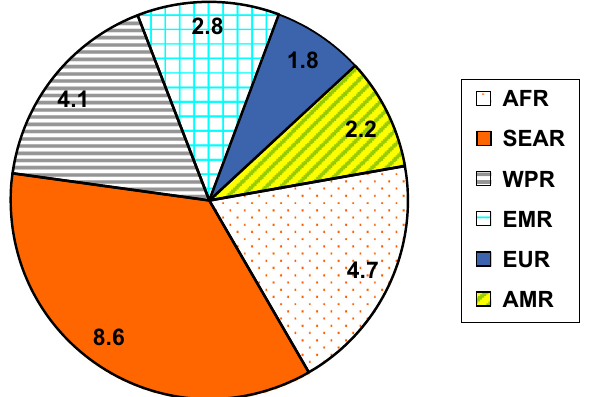
Figure 1. Chart depicting figures for the road traffic injuries (in millions) for the WHO regions (AFR – Africa, SEAR – South East Asia, WPR – Western Pacific, EMR – Eastern Mediterranean, EUR – Europe, AMR –